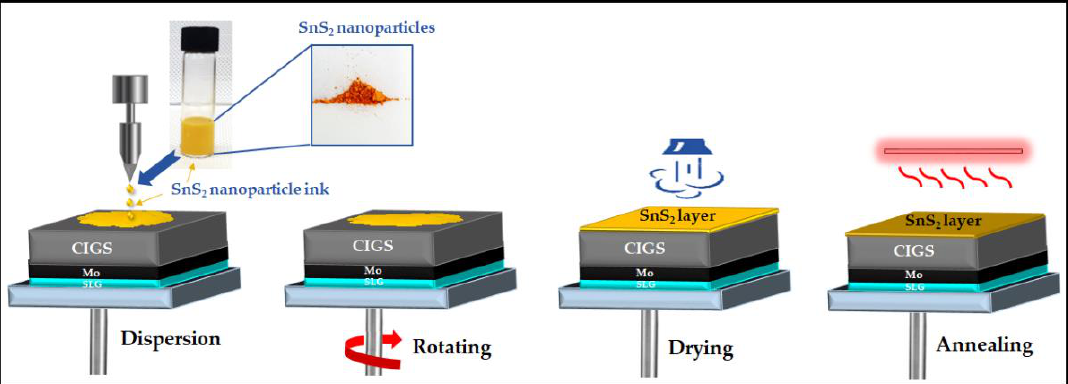
Figure 2. Schematic representation of SnS 2 thin film preparation.